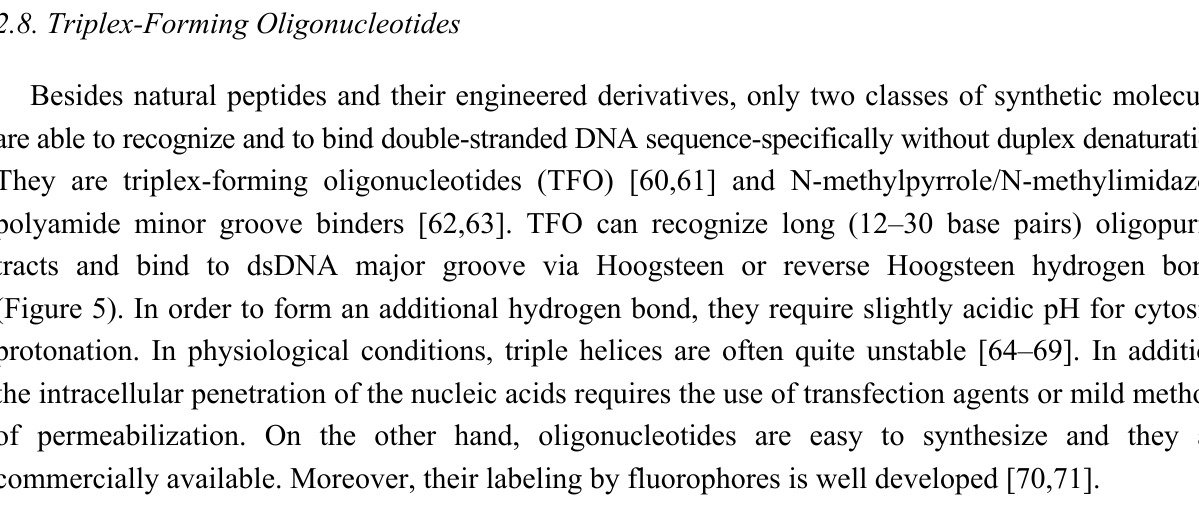
Figure 4. ( a ) Primary structure of the TALE element recognizing one base pair. 12-th and 13-th amino acids (XX in red) determine the element specificity. ( b ) Recognition code of the TALE elements